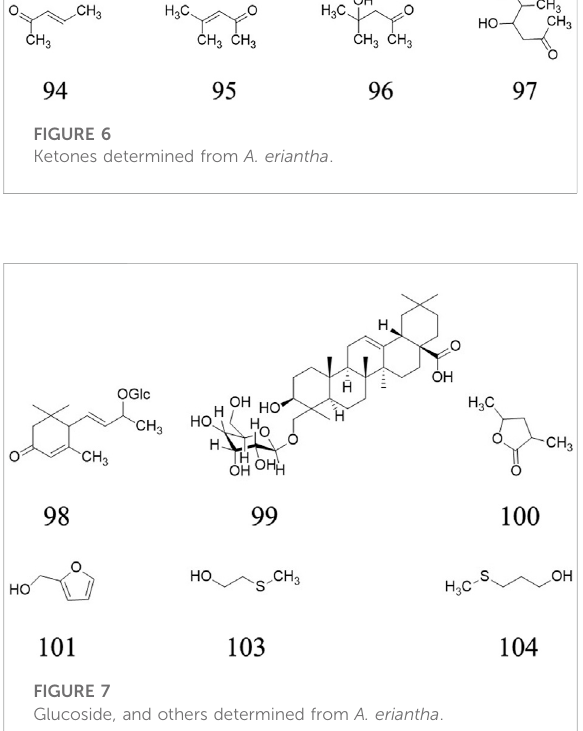
FIGURE 7 Glucoside, and others determined from A. eriantha